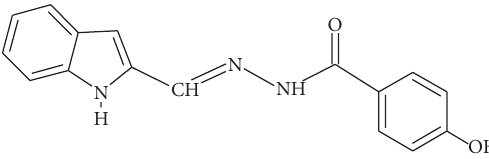
Figure 1: Chemical structure of HIBH